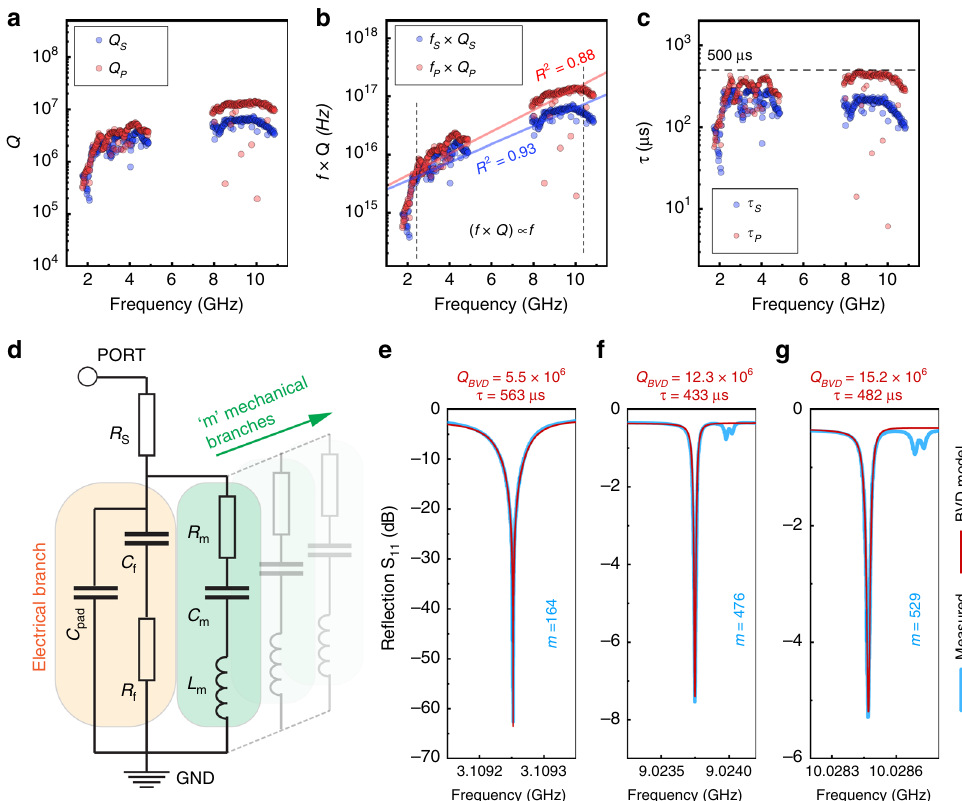
Fig. 3 High mechanical quality factors and phonon lifetimes for the epi-HBAR. a Measured quality factors (for phonon modes that exhibit at least a half- power bandwidth) for the epi-HBAR are greater than 10 million (at frequencies greater than 10 GHz) at 7.2 K, some of the best values measured to date for BAW resonators. b The f × Q products show that ( f × Q ) ∝ f , characteristic of the Landau – Rumer regime for anharmonic phonon scattering. The dashed lines denote linear fi ts, with goodness of fi t ( R 2 ) values of 0.93 and 0.88 for series and parallel modes respectively. c The phonon relaxation times ( τ ) for the measured epi-HBAR is as high as 500 µ s. The phonon relaxation time effectively sets the upper bound for the time that a quantum state can be stored or manipulated in a QAD system. d A Butterworth-van Dyke (BVD) equivalent circuit is used to model multimode mechanical resonators. Each mechanical branch is modeled as a virtual resonant circuit that represents a single phonon mode; the electrical branch models all electromagnetic losses and feedthrough associated with the epi-HBAR and the coplanar waveguide. Panels ( e – g ) show measured S 11 ( ω ) for three epi-HBAR modes ( m = 164, m = 476, and m = 529) (blue) along with corresponding BVD model fi ts (red). Measured and modeled quality factor and relaxation time (Methods) for each mode validates the high f × Q and τ , demonstrating f × Q > 10 17 Hz and τ > 500 μ s, respectively, for microwave phonons at 7.2 K in Al/GaN/NbN/SiC epi-